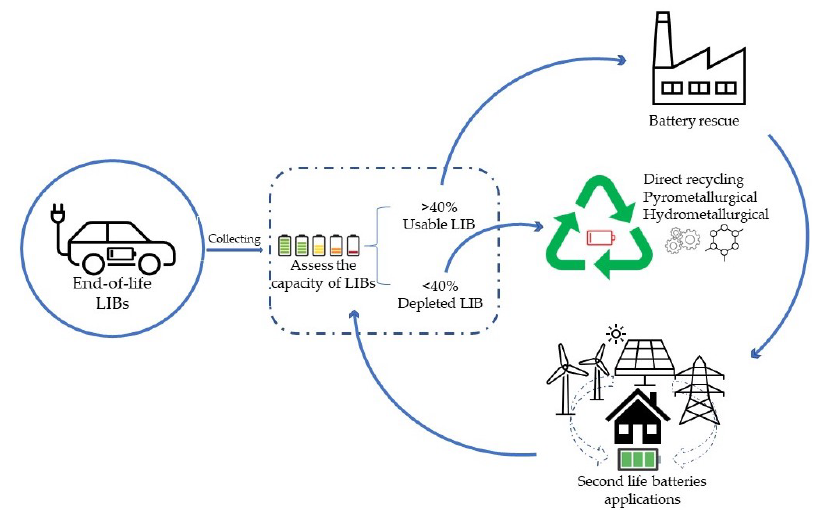
Figure 1. Main end-of-life LIB management processing by reuse and recycling.